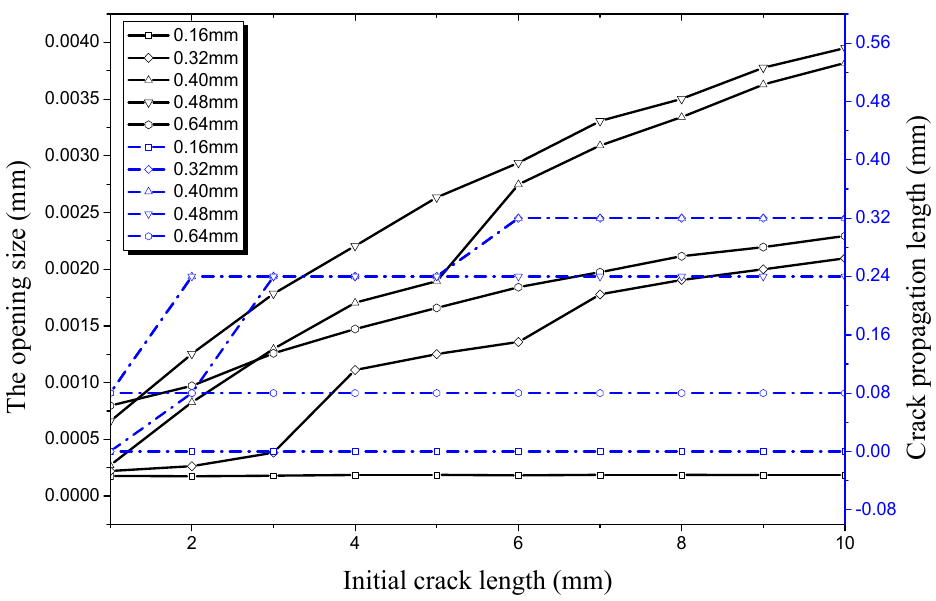
Figure 18. Relationship between radial crack propagation length and initial crack length on the outer surface, and relationship between radial opening size and initial crack length on the outer surface, both under an internal pressure of 28 MPa.